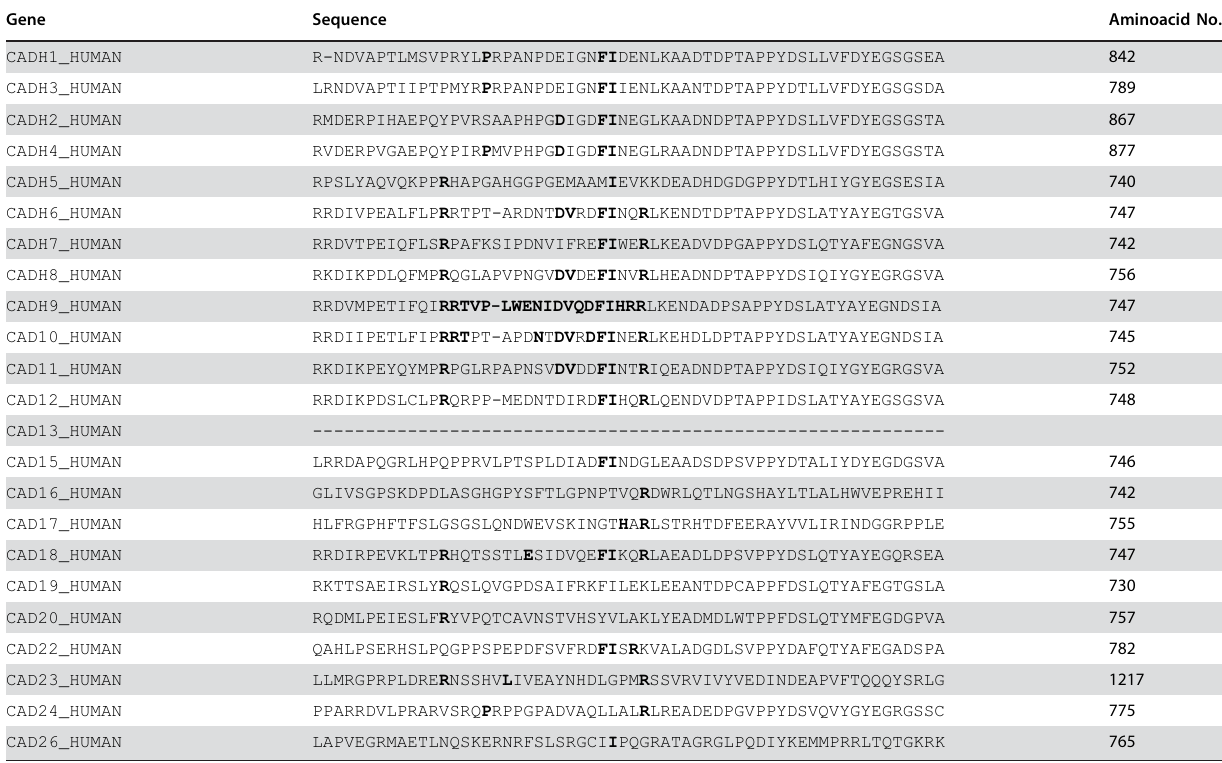
Bold letters mark the peptide, which was used for the generation of the cadherin-9 specific antiserum and the matching amino acids in the other cadherin-family members. There are only few conserved amino acids, especially in the cadherin-6 and -10 sequences.